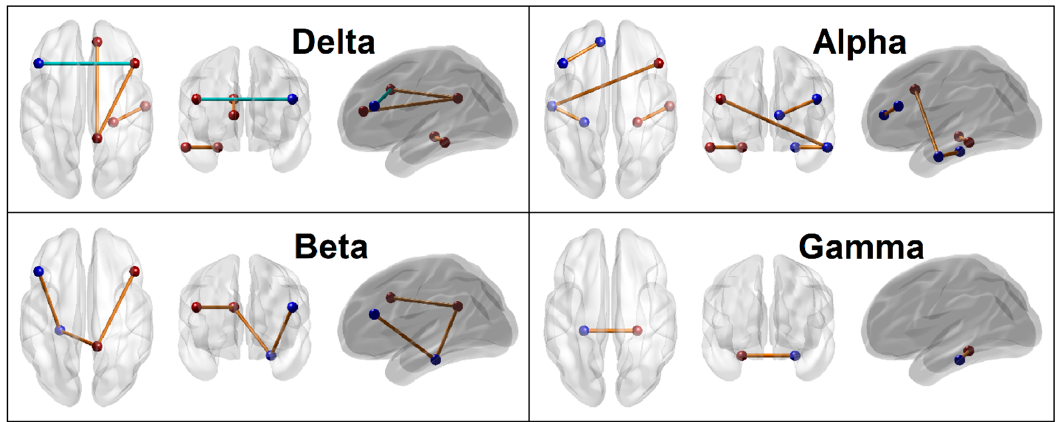
Figure 6. Significant default mode network (DMN) connections based on a stricter threshold ( p ≤ 0.001) are shown. The three images within each panel representing specific frequency represent these three views, respectively: axial or top view, coronal or front view, and sagittal or left view. The blue and red beads represent left and right-sided DMN nodes/seeds respectively, and the connections represented in orange and cyan lines indicate hyper- and hypo-connectivity, respectively, in alcohol use disorder (AUD) compared to control group.